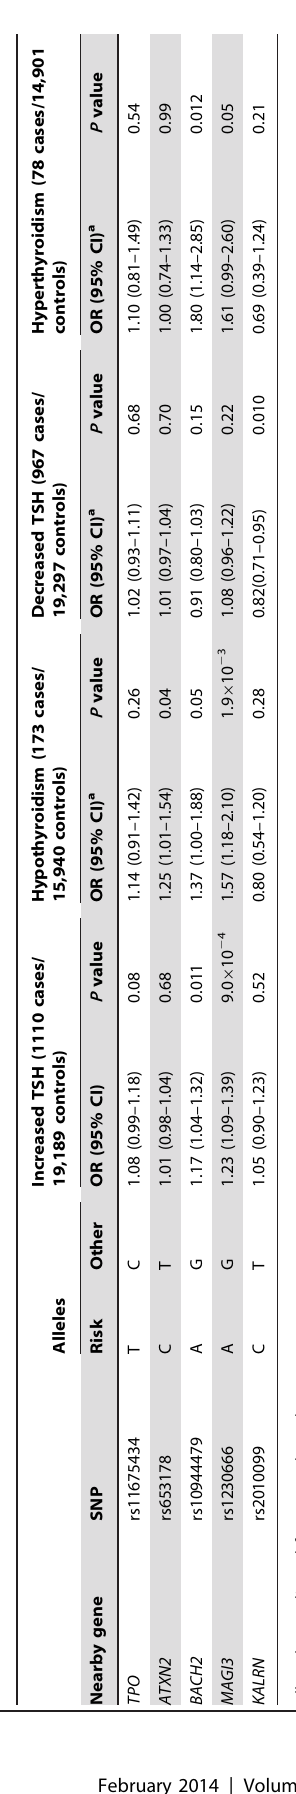
Table 3. Genetic risk score and the risk of TPOAb-positivity.